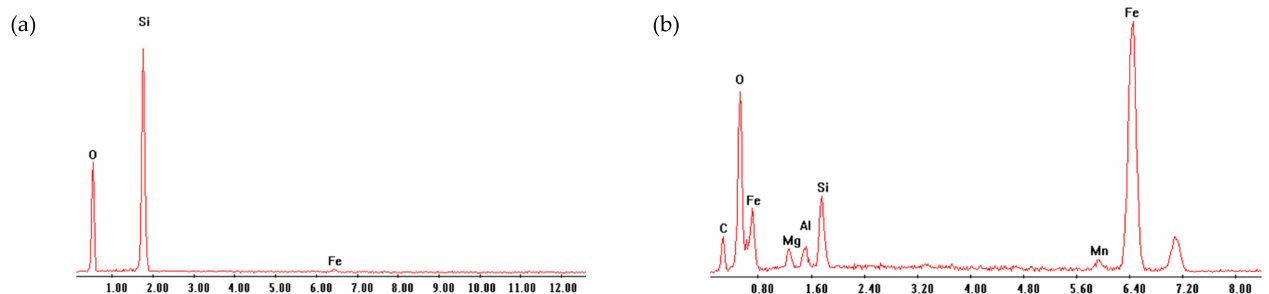
Figure 16. EDS pattern of ( a ) the defect observed in the fracture surface shown in Figure 15; ( b ) the material region closed to the